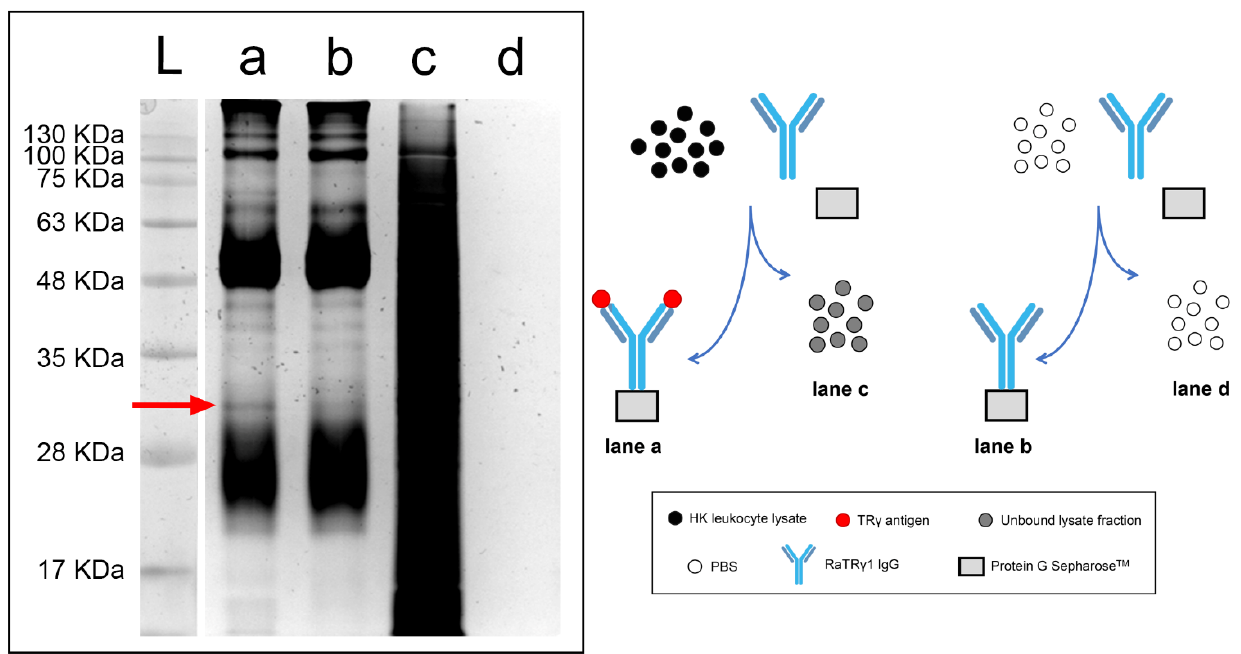
Figure 1. Immunoprecipitation analysis. SDS-PAGE of HK leukocyte lysate immunoprecipitated with RaTR γ 1 IgG and stained with the ProteoSilver™ Stain kit. Lane a: Protein G Sepharose ® -precipitated PAb incubated with the HK leukocyte lysate. Lane b: Protein G Sepharose ® -precipitated PAb incubated with PBS. Lanes c and d: PAb-unbound supernatant fraction of HK leukocytes and PBS, respectively. The red arrow indicates the TR γ antigen, which is specifically recognized by RaTR γ 1 IgG. The ladder is indicated by L. On the right, a schematic representation of the SDS-PAGE results.